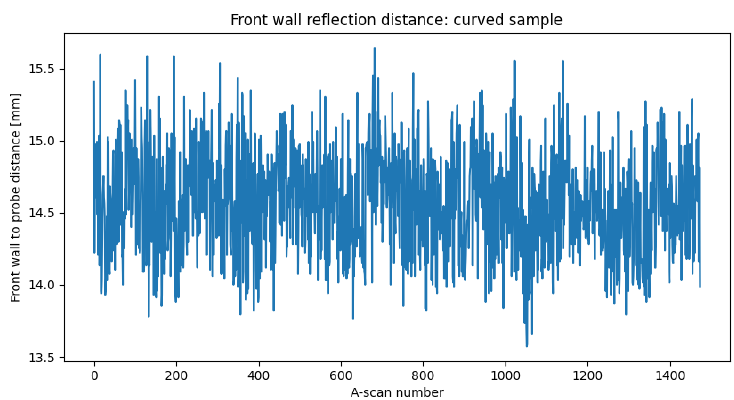
Figure 11. The maximum signal response for each A-scan used to calculate probe-surface